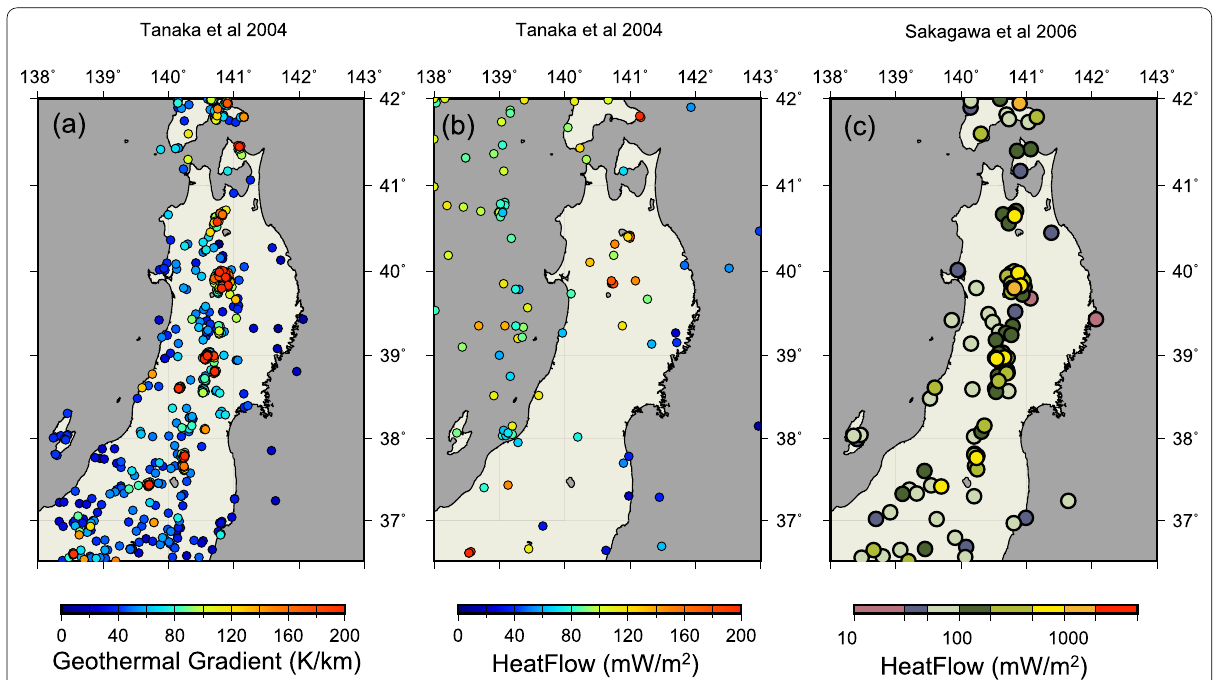
Fig. 8 Temperature gradient and heat flow distribution in previous studies. a Distribution of thermal gradient compiled by Tanaka et al. (2004). b Distribution of heat flow compiled by Tanaka et al. (2004). c Distribution of heat flow estimated by Sakagawa et al. (2006)